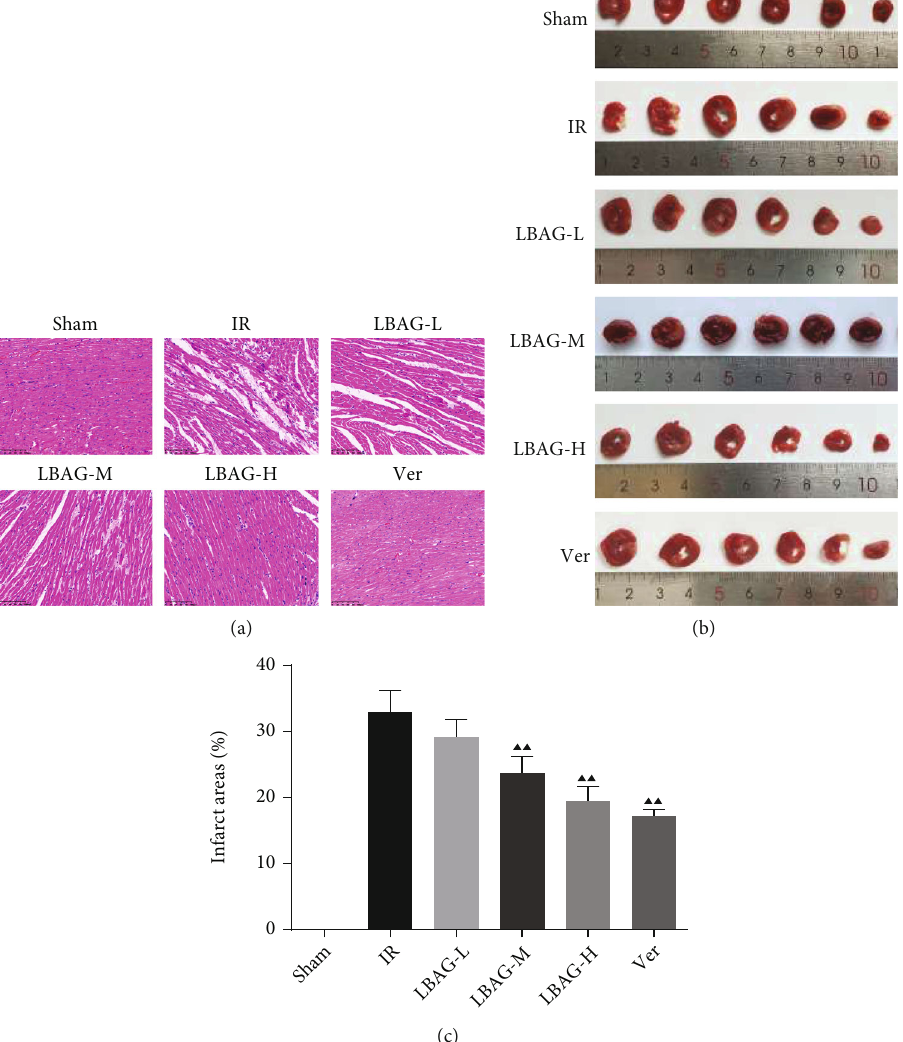
Figure 3: E ff ect of LBAG on pathological features of heart in rats. (a) The histopathological changes of the heart in LBAG-treated I/R- injured rats were measured through HE staining (scale bar, 100 μ m). (b) Representative TTC-stained images of the heart in LBAG- treated I/R-injured rats. (c) Quantitative analysis of myocardial infarction area. ▲ P < 0 : 05 and ▲▲ P < 0 : 01 vs. IR